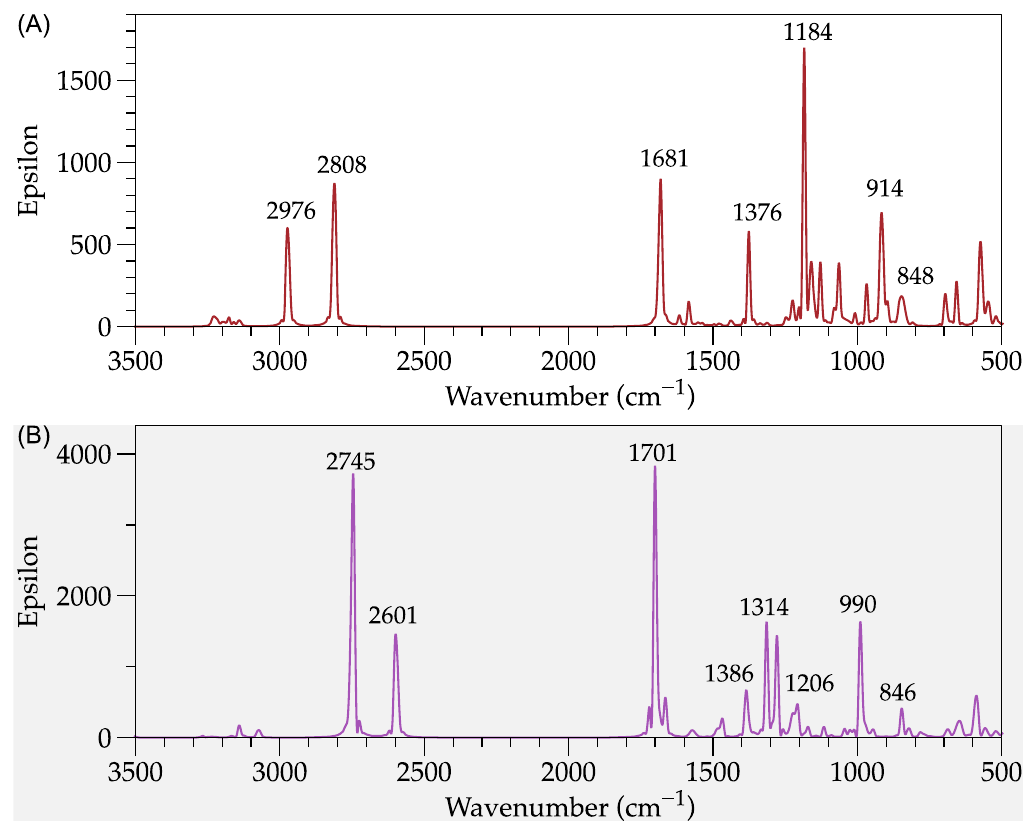
Figure 2. Modeled FT-IR spectra. ( A ) ani-SS; and ( B ) ani-AMPS.